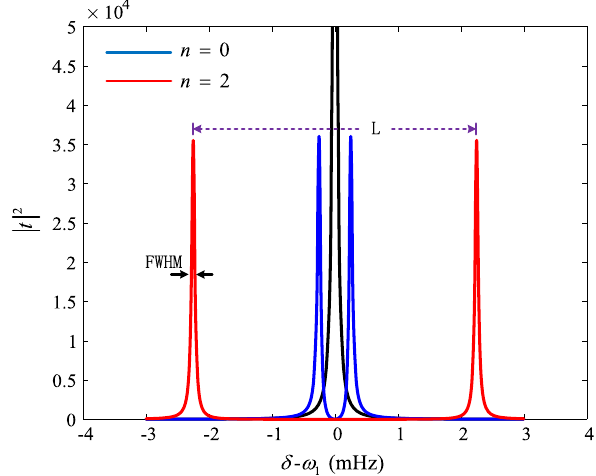
Fig. 2 The n = 2 extra dimensions modulate the transmission spec- trum of the probe field. A peak splitting caused by gravitational devia- tion and Casimir coupling can be well recognized in the spectrum